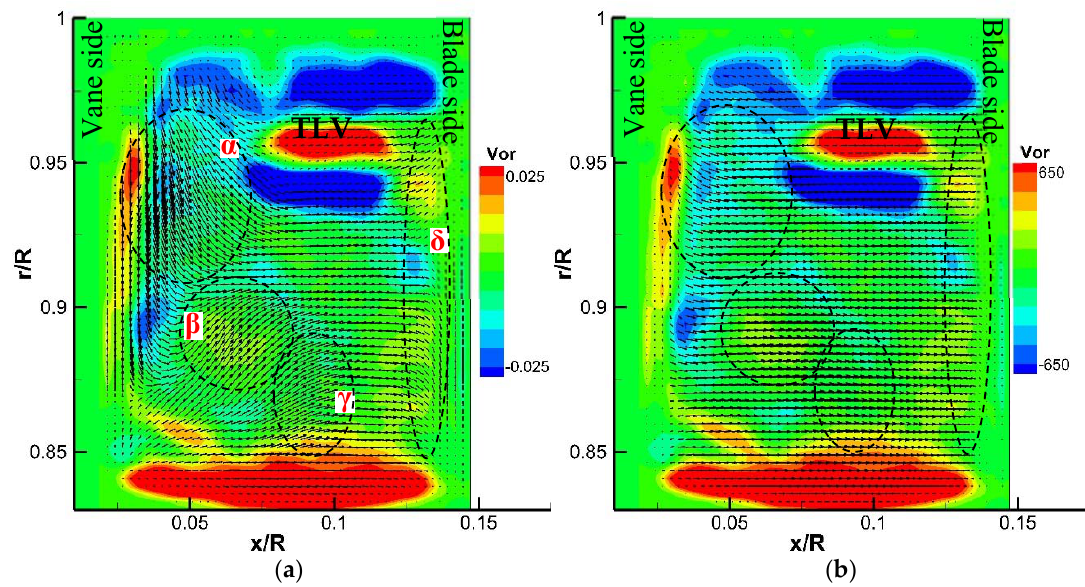
Figure 11. Vector field of MP7 with vorticity contour plots. ( a ) First order mode; ( b ) Time-averaged velocity field .